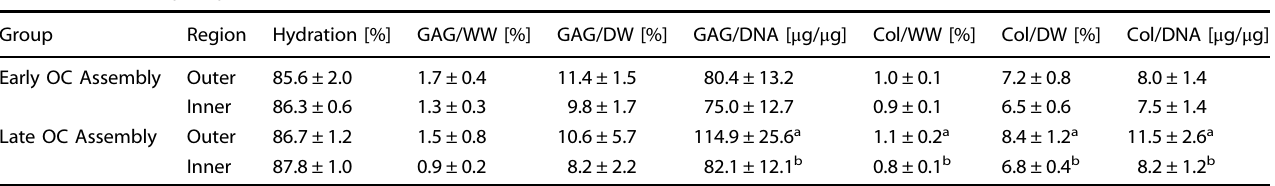
Table 1. Neocartilage regional biochemical